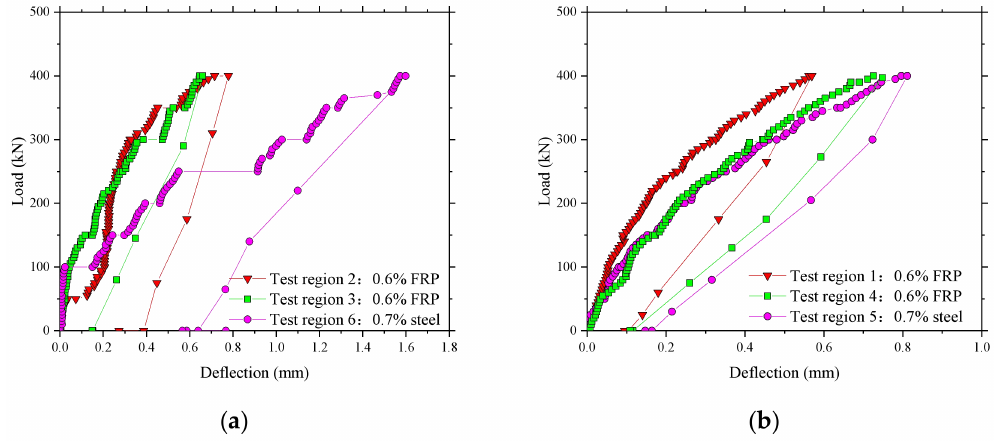
Figure 8. Comparison of midspan vertical deflections in the test areas. ( a ) The test areas between the W-beams; ( b ) The test areas between W-beams and